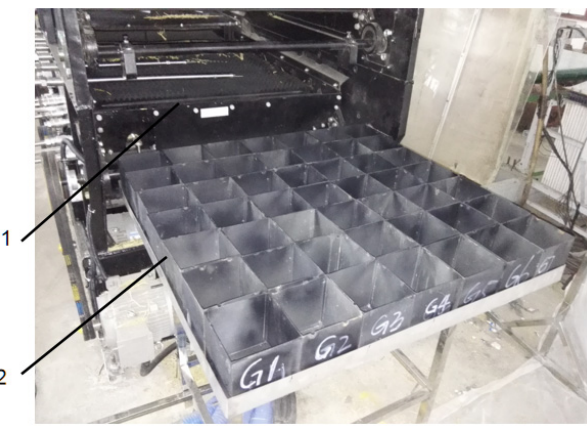
Figure 4. Schematic diagram of material receiver boxes. ( 1 ) vibration sieve; ( 2 ) receiver box.